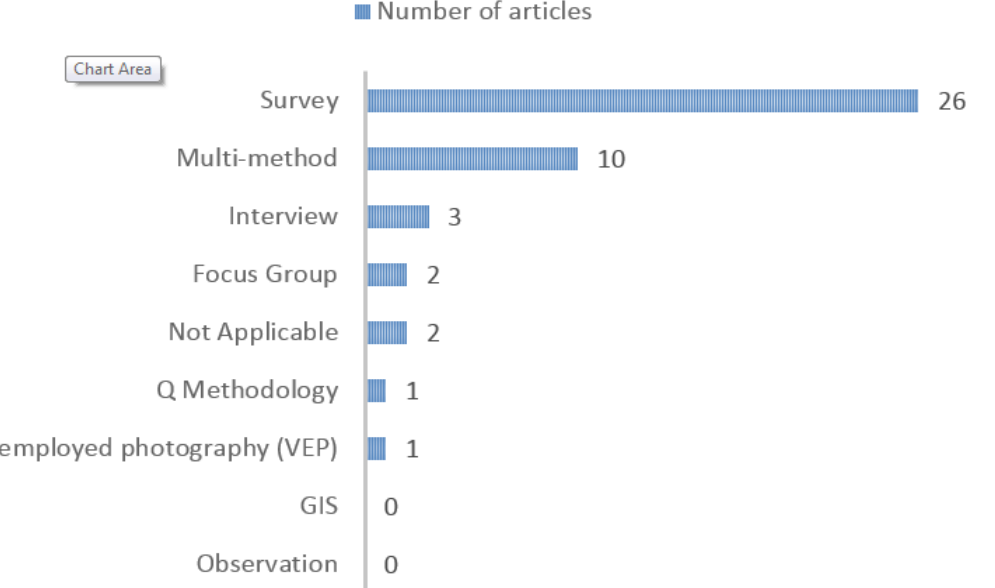
Figure 5: The methodology used in understanding greenspaces perceptions and preferences